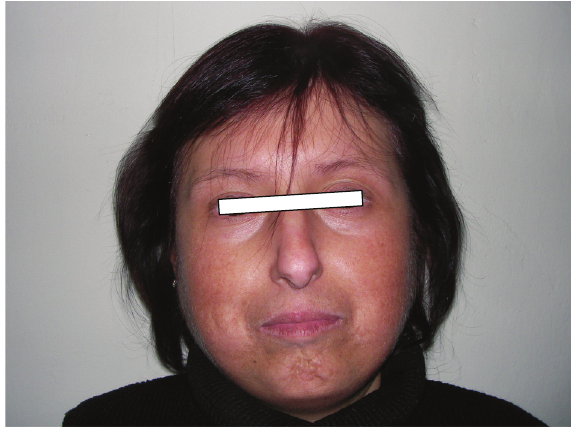
Figure 1: Case 1.